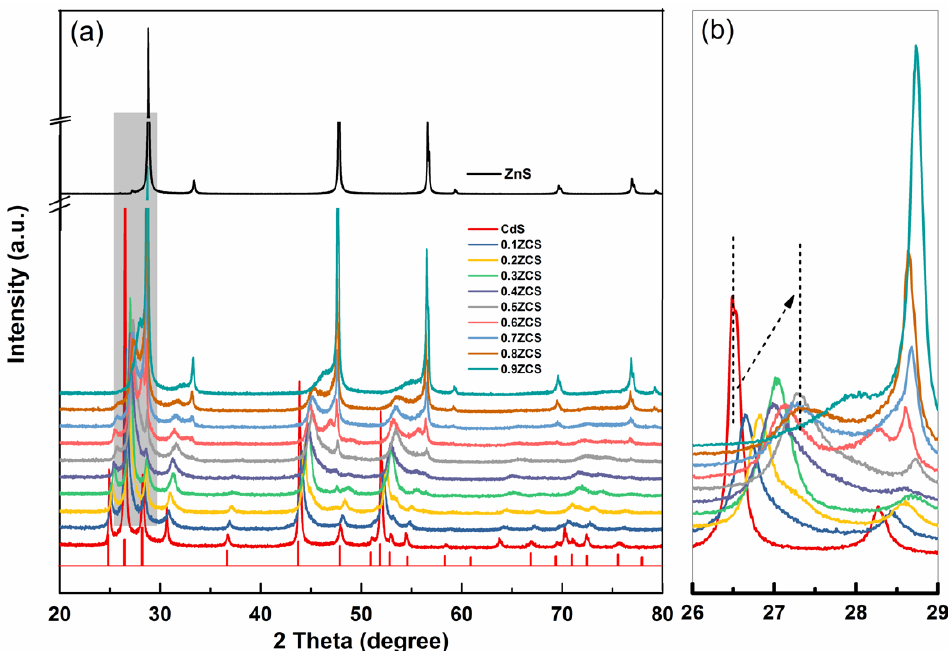
Figure 1. ( a ) XRD patterns of the prepared CdS, ZnS, and xZCS samples, ( b ) local enlarged patterns. Table 1. Elemental composition and characterization results of the prepared samples.